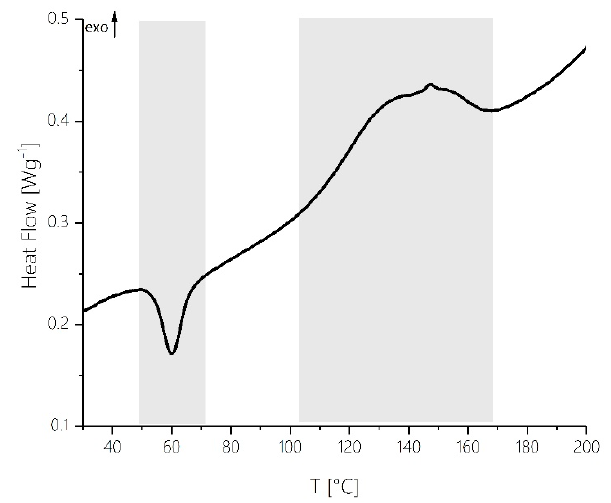
Figure 5. DSC trace recorded during MF resin cure in a temperature range from 30 to 200 ◦ C at a heating rate of 2 ◦ C min − 1 . Please note, that the reference signal was not subtracted from the sample signal .